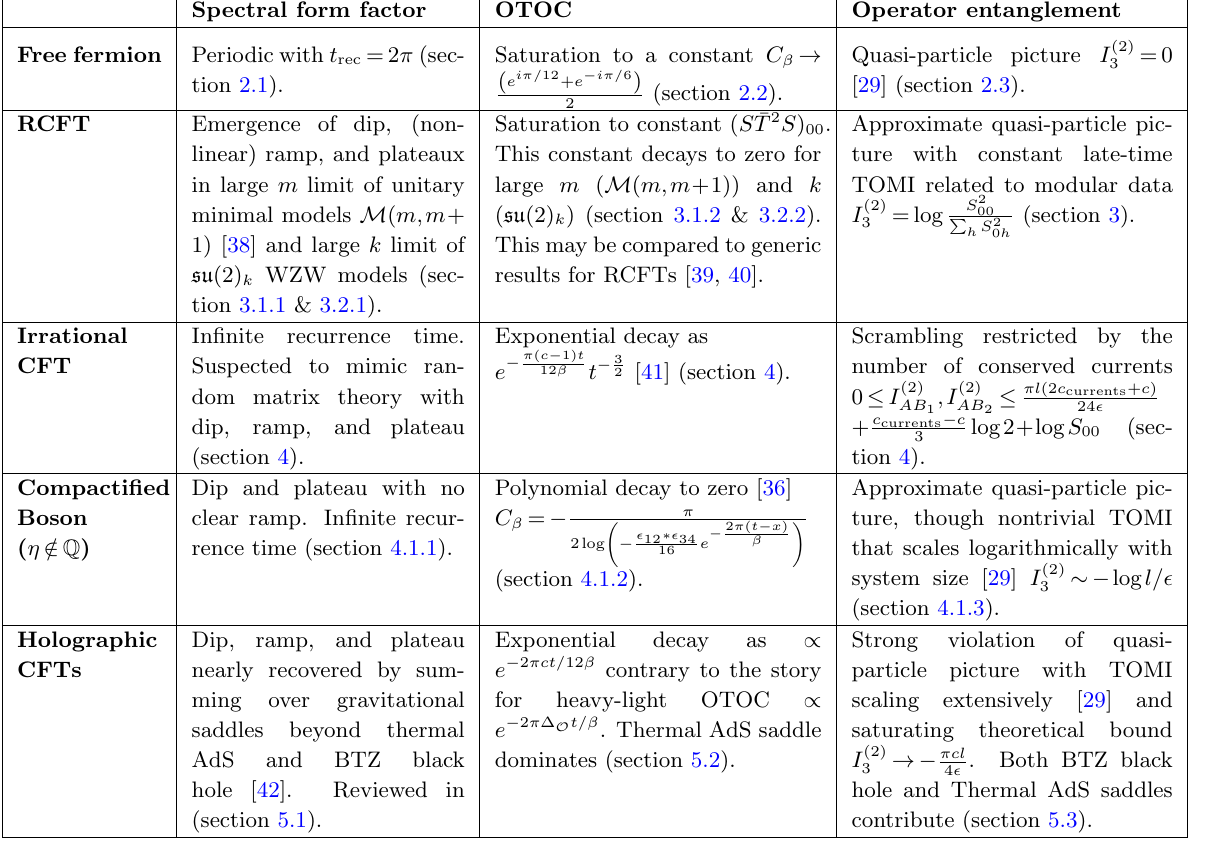
Table 1 . Summary of results and related